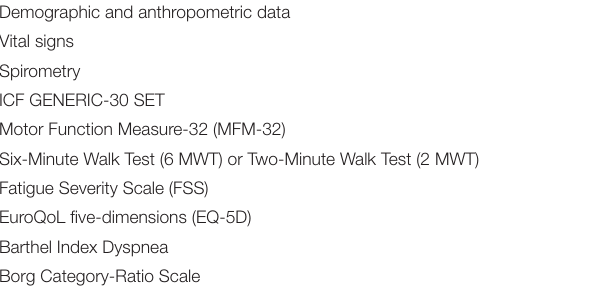
TABLE 3 | Our proposed evaluation protocol for people affected by NMDs post